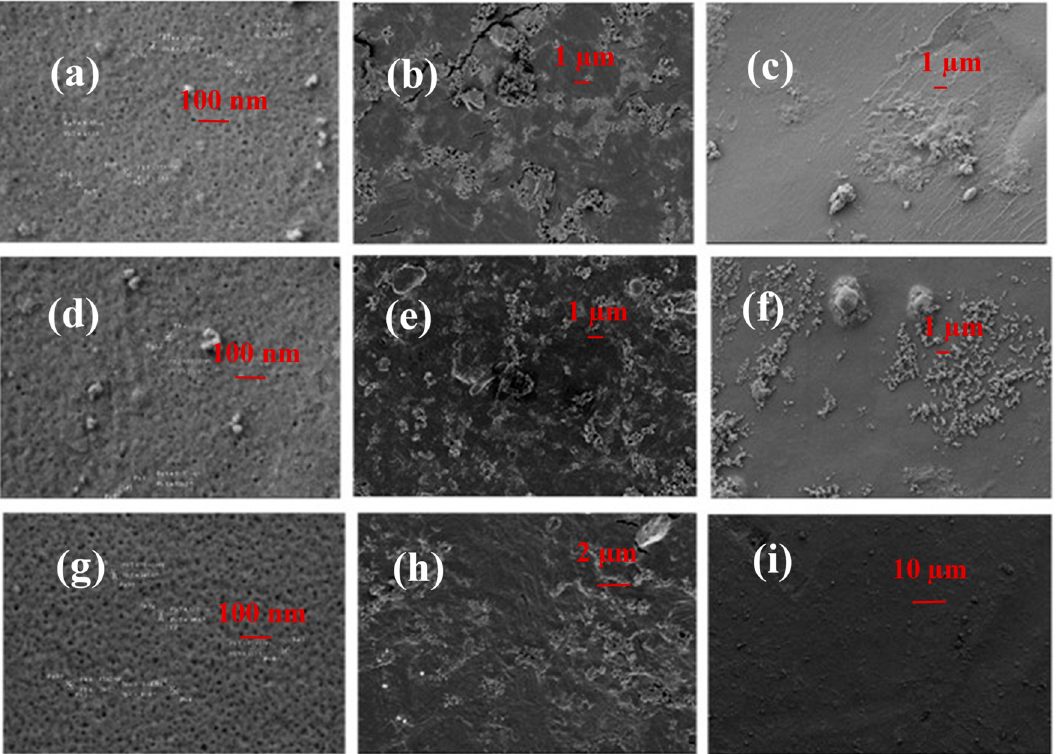
Figure 10. Field emission scanning electron microscopy (FESEM) images of the membrane surfaces ( a ) fresh 10 kDa MWCO, ( b ) fouled 10 kDa MWCO, ( c ) cleaned 10 kDa MWCO; ( d ) fresh 50 kDa MWCO, ( e ) fouled 50 kDa MWCO, ( f ) cleaned 50 kDa MWCO; ( g ) fresh 100 kDa MWCO, ( h ) fouled 100 kDa MWCO, ( i ) cleaned 100 kDa MWCO. Table 9. Inorganic composition of fresh and fouled membranes.